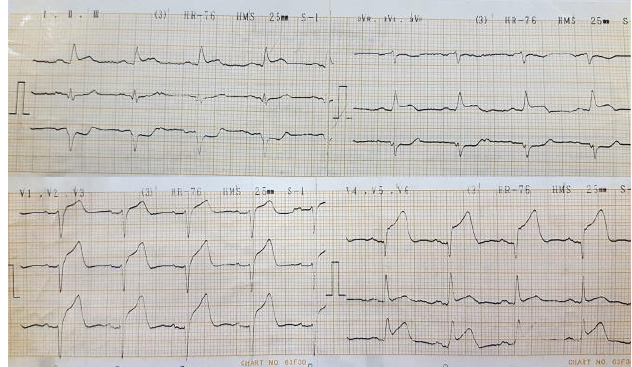
Figure 1. Electrocardiogram showing sinus